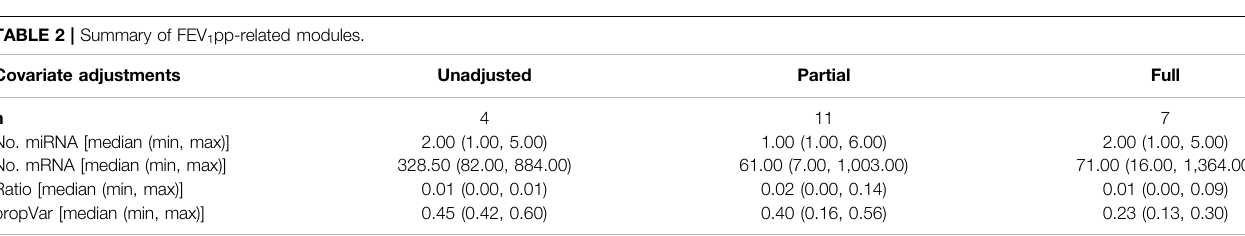
TABLE 2 | Summary of FEV 1 pp-related